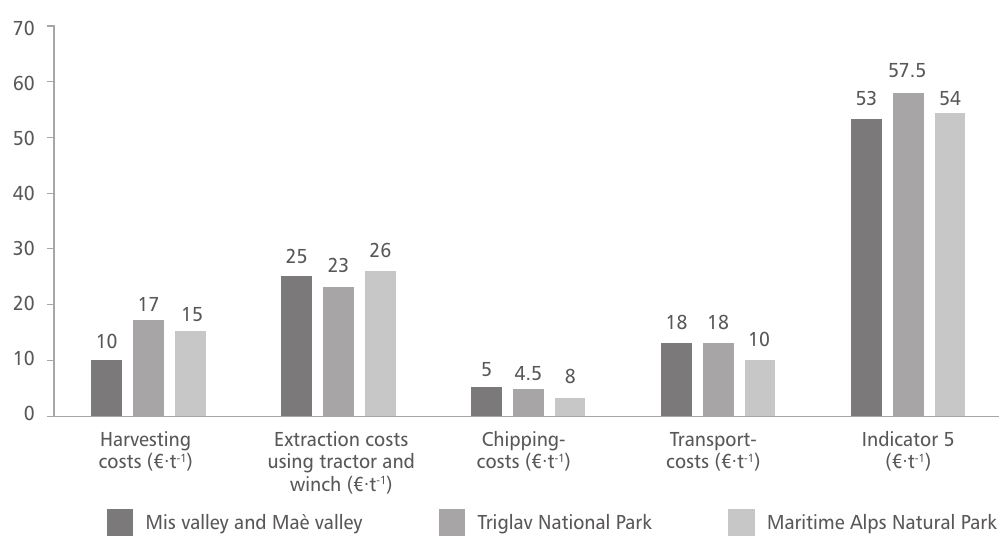
FIGURe 2. Average costs for wood chips production included the labour costs by case study (source: